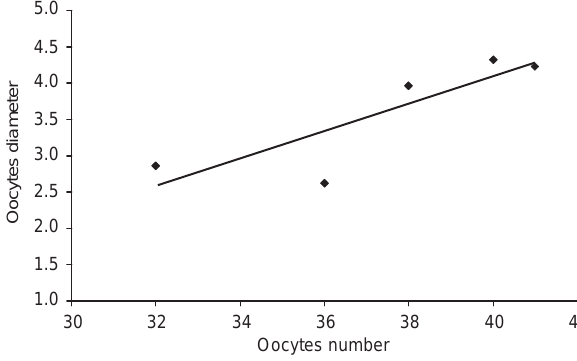
Figure 6. Relationship between the number and diameter of oo- cytes (mm) of females of H. luederwaldti recorded in the Parque Estadual de Campos do